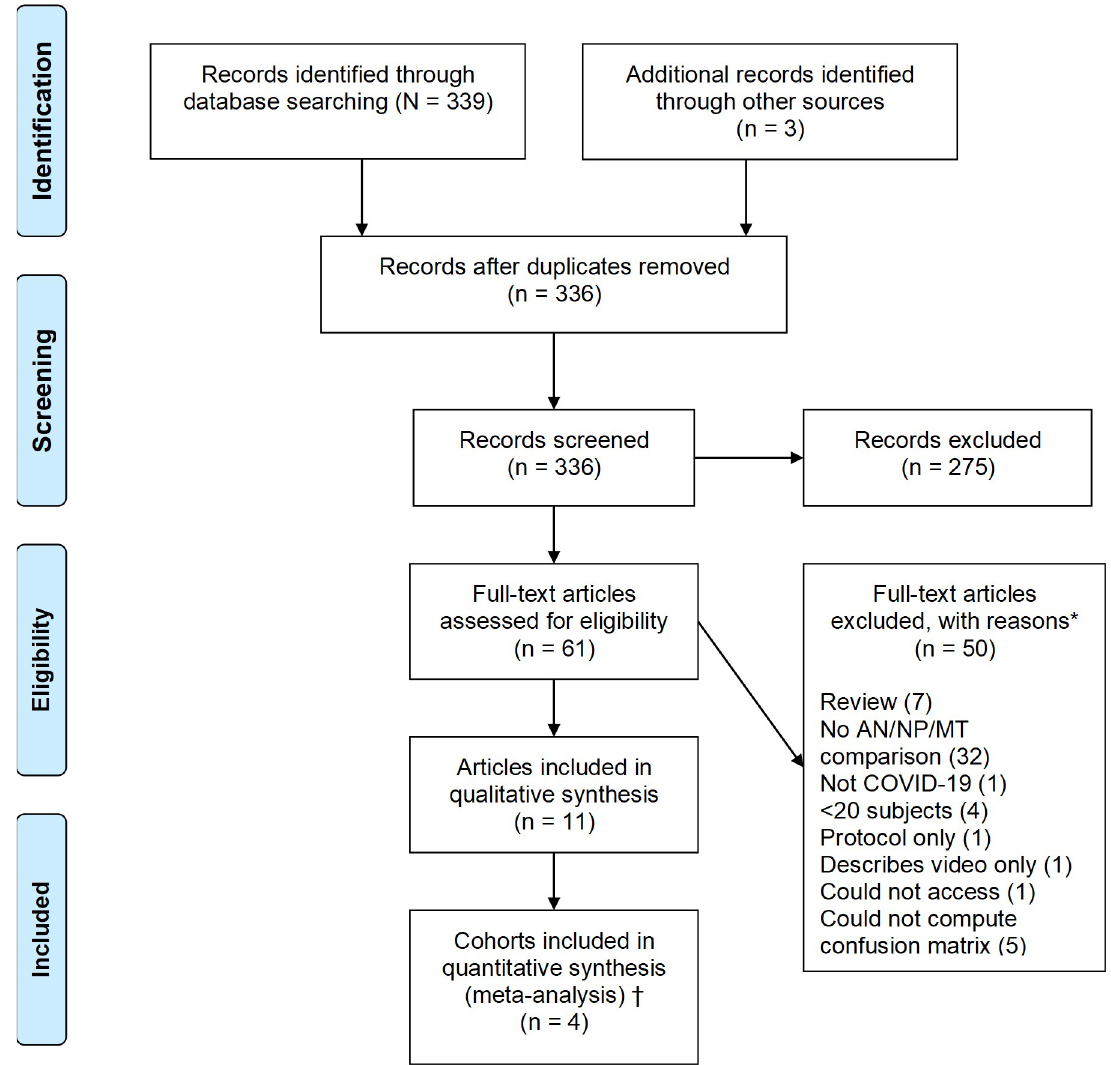
Fig 1. Preferred Reporting Items for Systematic Reviews and Meta-Analyses (PRISMA) flow diagram. � Some papers excluded for more than one reason †Meta-analysis performed with and without studies that had risk of selection